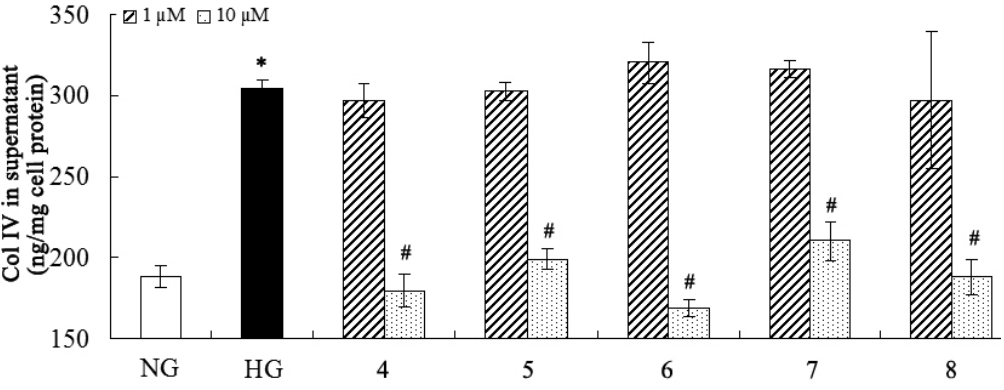
Figure 4. Inhibitory effect of the compounds on collagen IV. * p < 0.05 vs . normal glucose; # p < 0.05 vs. high glucose.